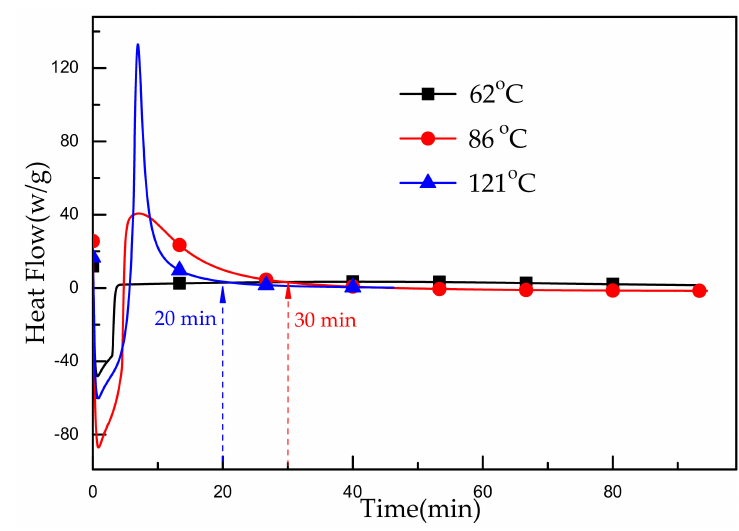
Figure 4. Isothermal DSC curves of the resin systems.